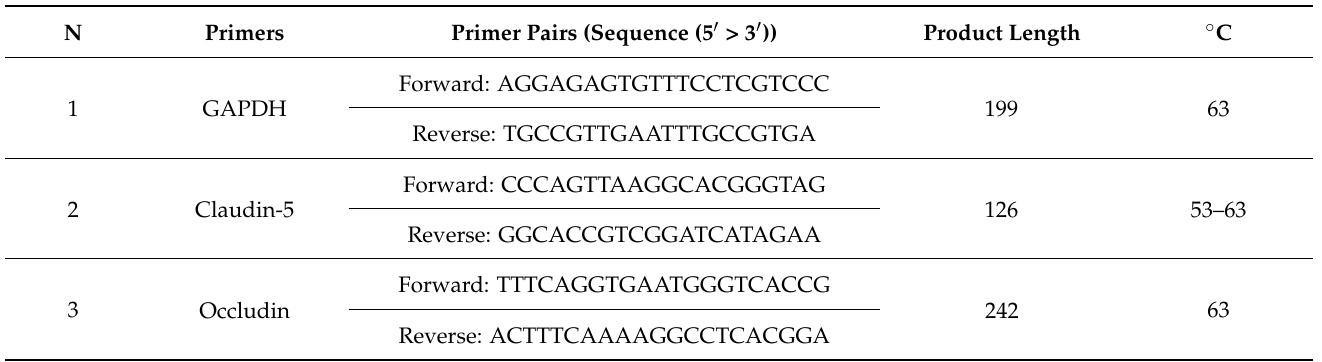
Table 1. Primer sequences for quantitative PCR (qPCR) amplification of complementary DNA (cDNA). GAPDH: glyceraldehyde phosphate